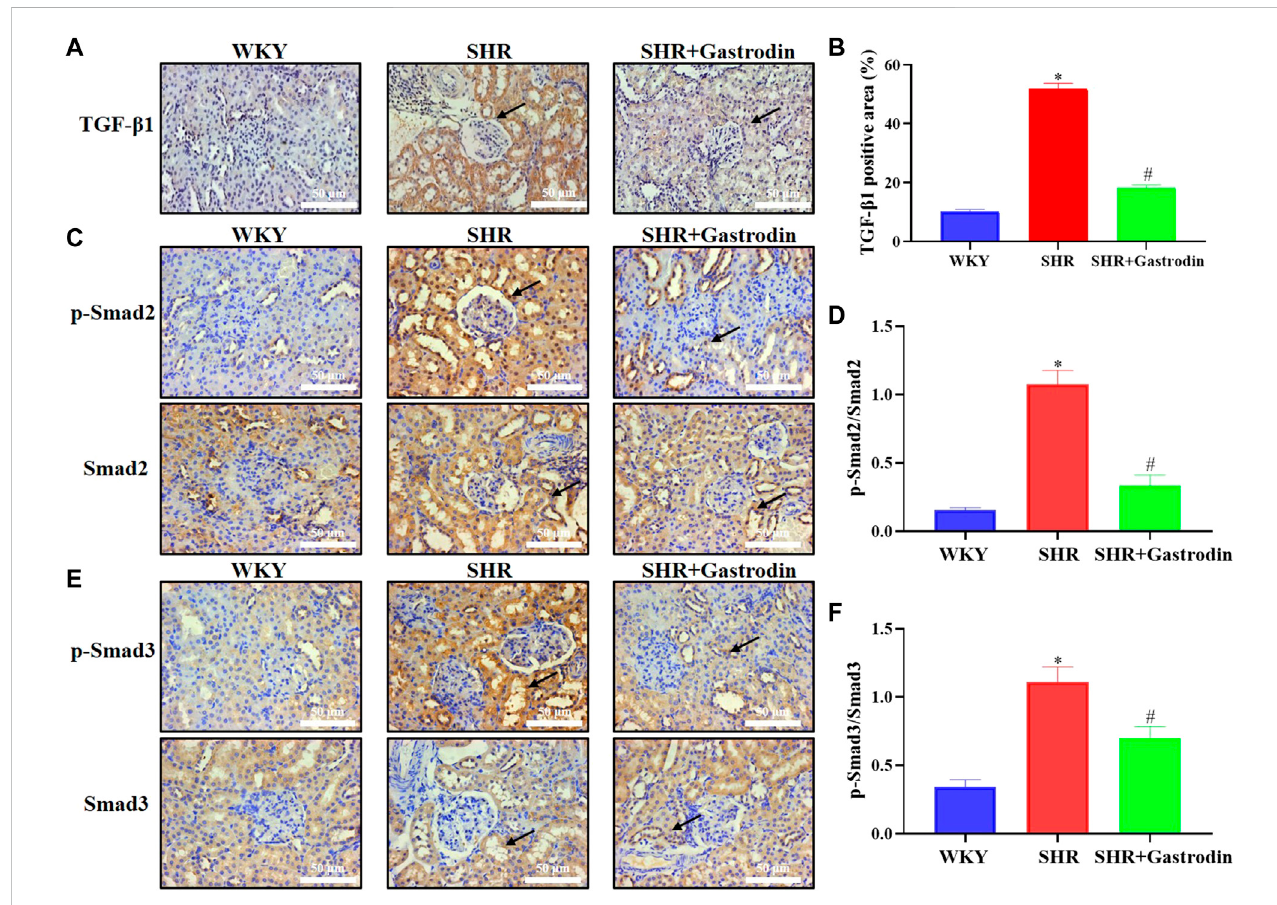
FIGURE 6 Gastrodin inhibited the TGF- β 1/Smad2/3 signaling pathway in vivo (A) Immunohistochemistry (IHC) was performed to measure the levels of TGF- β 1 in the renal tissues of rats. The positive areas in (B) TGF- β 1 staining cells in rats were calculated. IHC was performed to detect the expressions of (C) ratio of p-Smad2/Smad2 protein and the positive areas in (D) p-Smad2/Smad2 staining cells in rats were calculated in the renal tissues. IHC was performed to detect the expressions of (E) ratio of p-Smad3/Smad3 protein and the positive areas in (F) p-Smad3/Smad3 staining cells in rats were calculated in the renal tissues. All micrographs were taken at ×400 magni fi cation. Scale bar = 50 μ m. All values are mean ± SD ( n = 5 for each group). * p < 0.05 vs the WKY group, # p < 0.05 vs the SHR